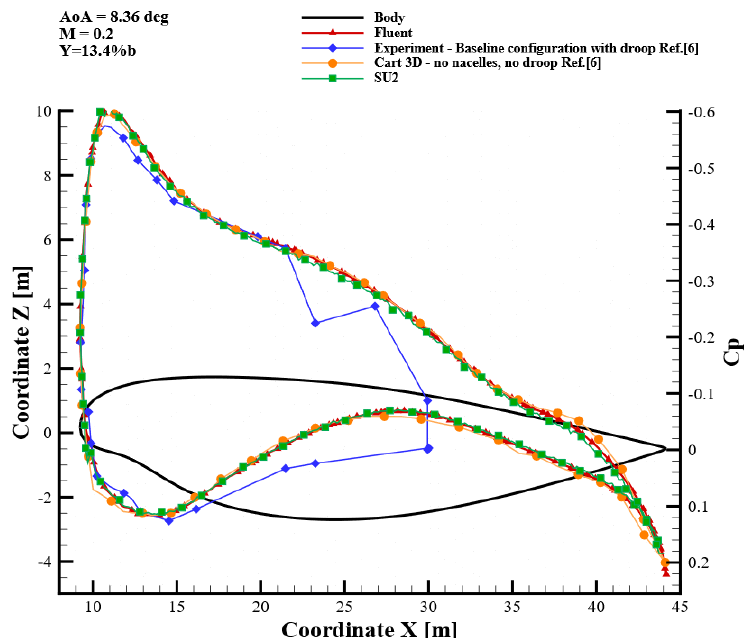
Figure 16. Chordwise pressure distribution at β = 13.4%. Comparison between present results and literature